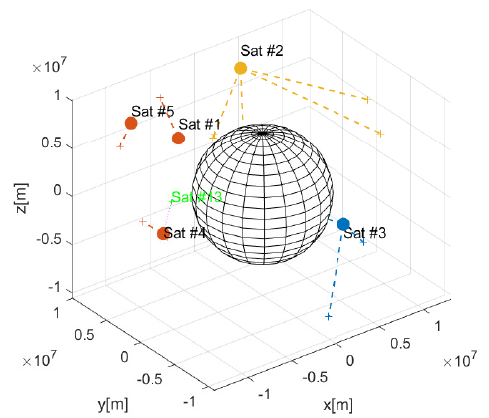
Figure 4. Updated task-planning visualization for results presented in Table 5. Filled circles, satellites; ‘+’, objects. Yellow, blue, and red represent Clusters 1–3, respectively. Urgent task represented as green ’+’ that is allocated to Satellite 4.